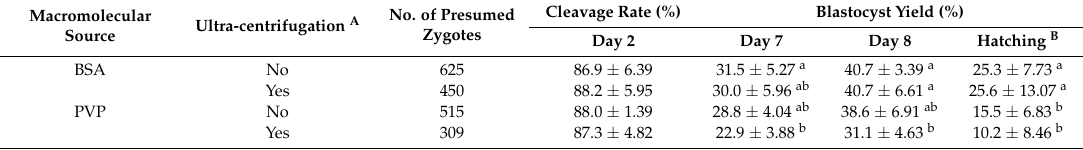
Table 1. Blastocyst development and hatching rate of bovine embryos cultured in BSA and PVP media. Macromolecular Source